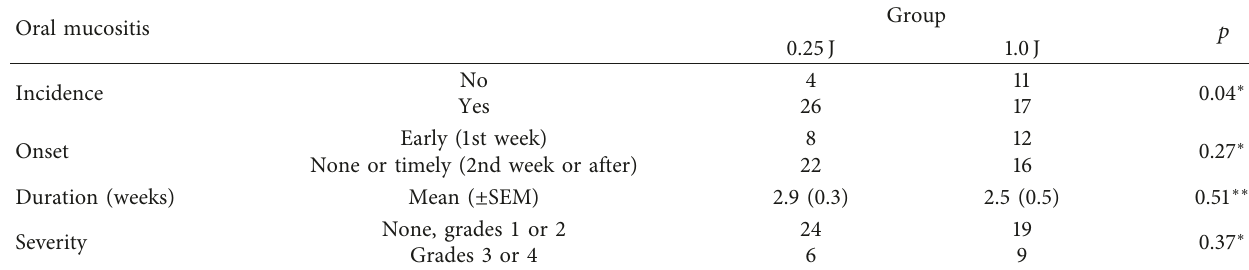
Table 4: Occurrence of oral mucositis.